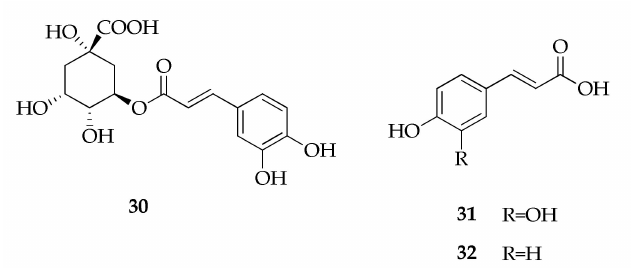
Figure 8. Structures of cinnamic acid derivatives.